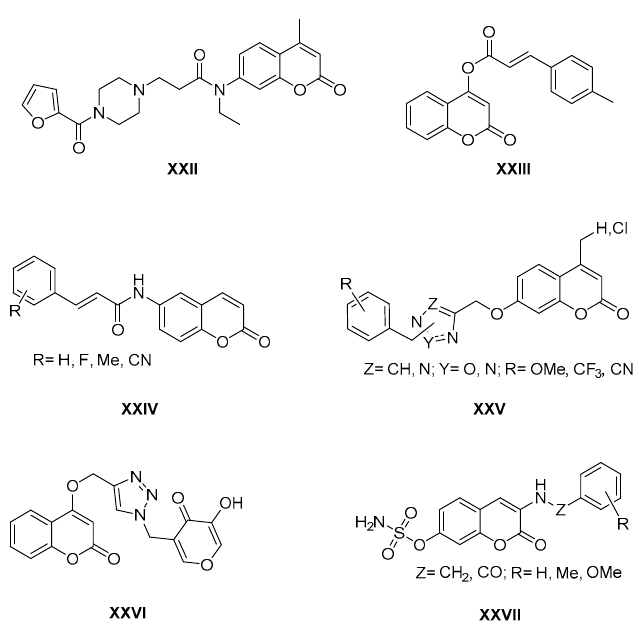
Figure 6. Structures of coumarin derivatives as enzymatic inhibitors.